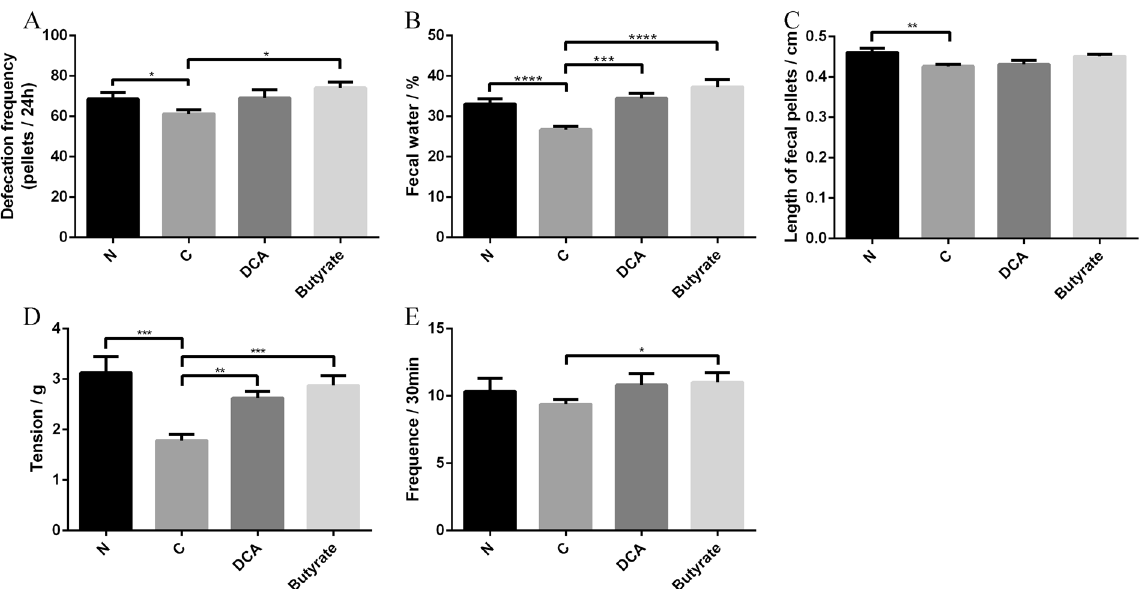
Figure 6. DCA and butyrate supplements have effects on defecation frequency ( A ), fecal water content ( B ), length of fecal pellets ( C ), and colonic contractility ( D : tension; E : Frequency) of mice receiving fecal microbiota from STC donors (DCA mice = 6, Butyrate mice = 6). Data represent the mean ± SEM. * p < 0.05, ** p < 0.01, *** p < 0.001, **** p < 0.0001. Group N: mice receiving fecal microbiota from healthy donor; Group C: mice receiving fecal microbiota from STC donors; Group DCA: mice receiving fecal microbiota from STC donors were treated with DCA; Group butyrate: mice receiving fecal microbiota from STC donors were treated with butyrate. STC: slow transit constipation; DCA: deoxycholic